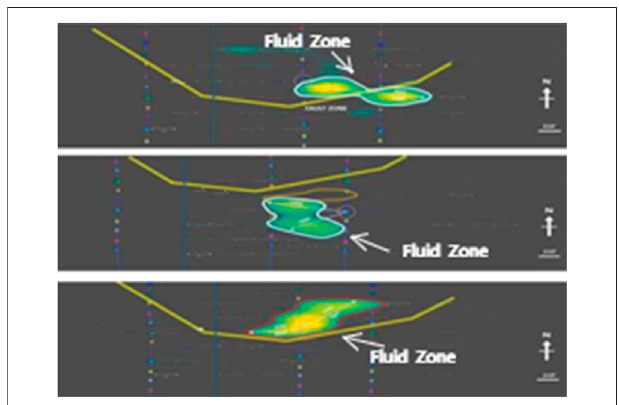
FIGURE 1 | Electromagnetic monitoring of fracturing fl uid aggregation pattern (Hickey et al., 2019).